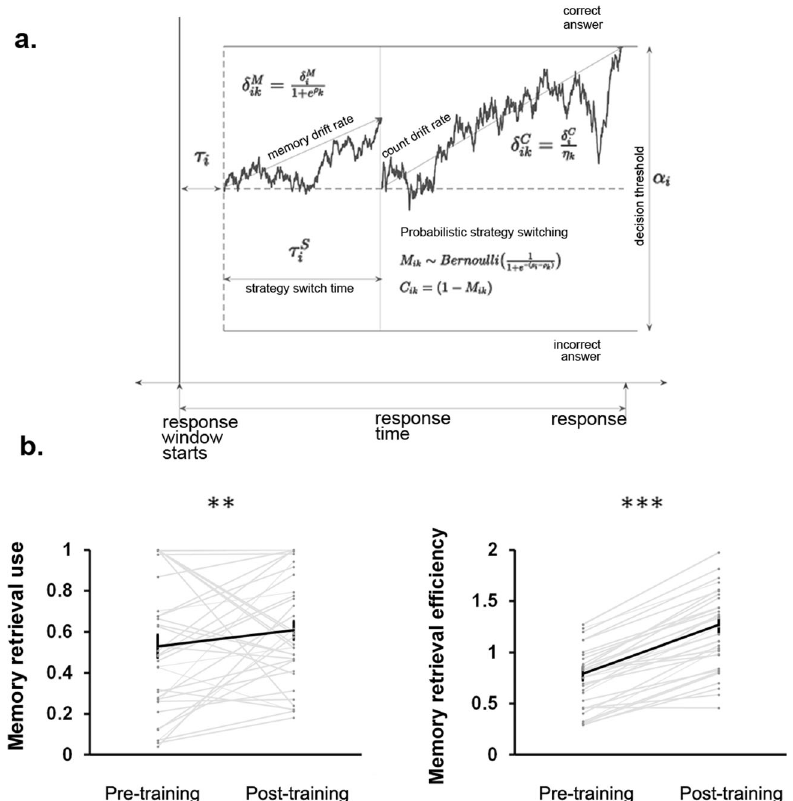
Fig. 2 Cognitive training increases the use and ef fi ciency of memory retrieval-based problem-solving strategy. a A dynamic latent cognitive model reveals multiple processes associated with problem-solving strategy use. The fi rst drift – diffusion process shows an early terminated memory retrieval process governed by memory retrieval related drift parameters (e.g., memory drift rate), which has not reached the decision threshold when the